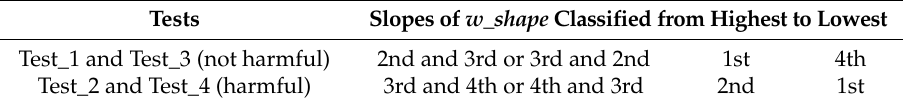
Table 5. Slopes of w_shape classified from highest to lowest (from left to